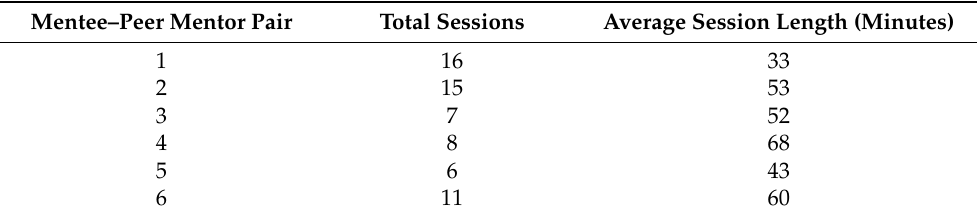
pletion between groups .